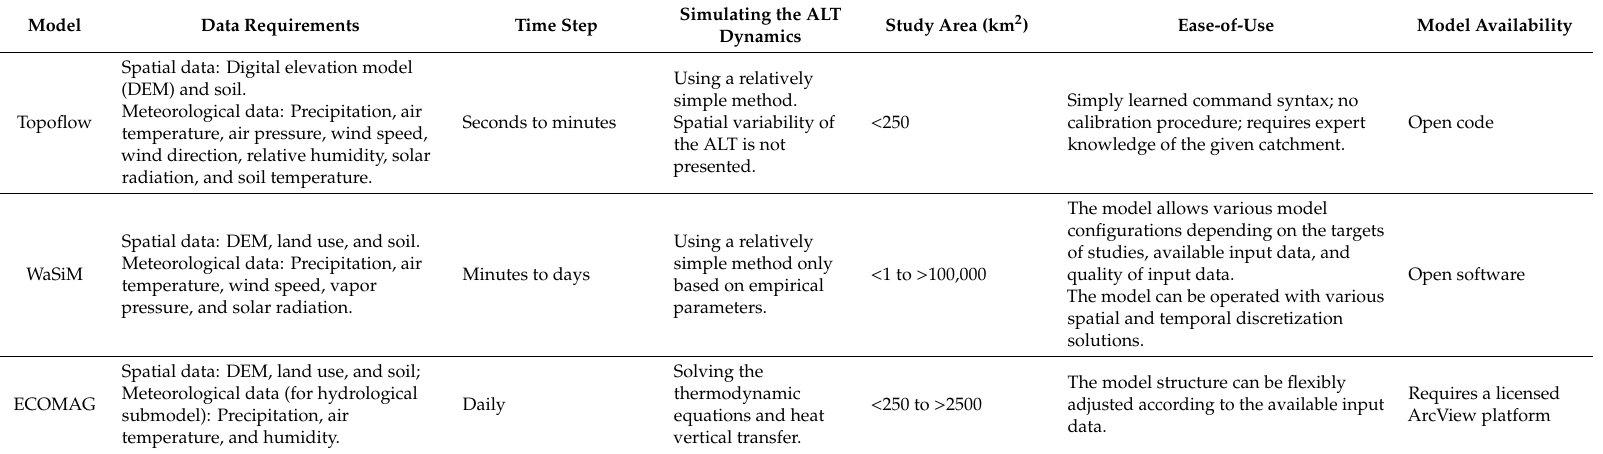
Table 2. Summarization of model